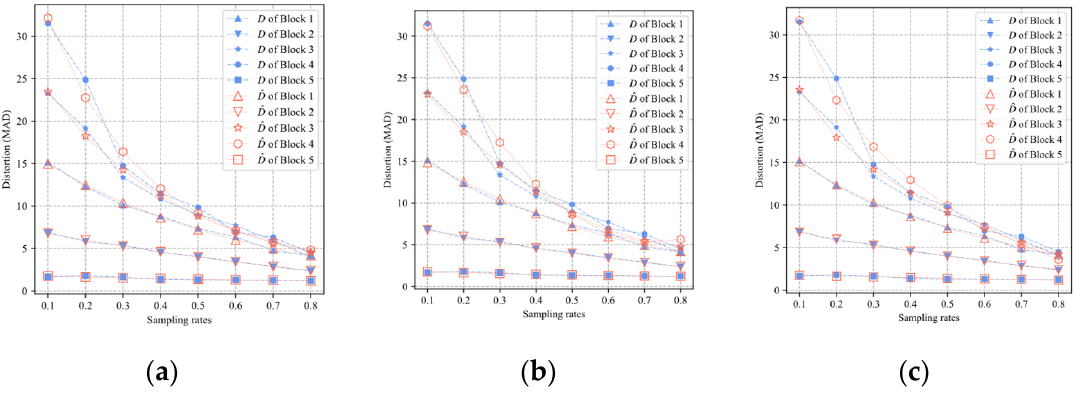
Figure 3. The predicted distortion ˆ D of five blocks of Lena for different models: ( a ) The exponential model; ( b ) the polynomial model; ( c ) the logarithmic model.